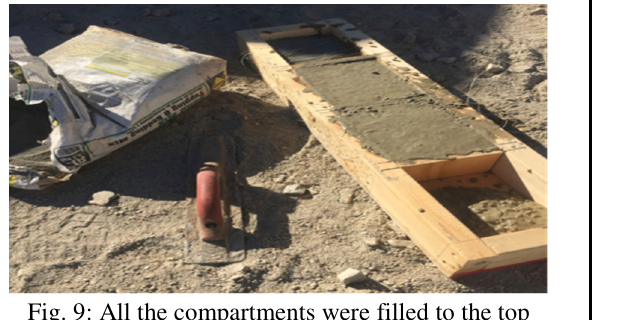
Fig. 9: All the compartments were filled to the top and levelled